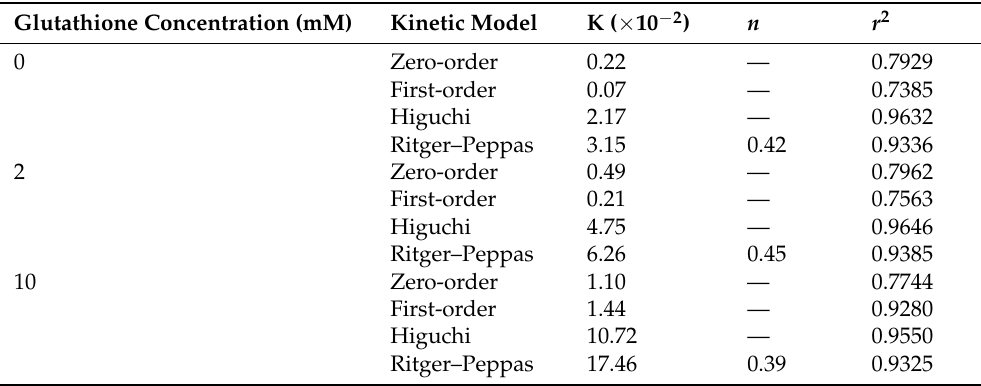
Table 2. Determined parameters of prochloraz released from PRO@DMON–GA–Fe(III) nanoparti- cles by fitting several kinetic equations.